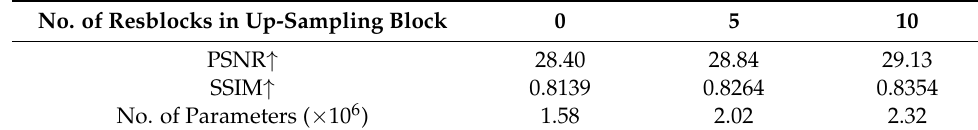
Table 4. Verification tests to determine the optimal number of pixel-shuffle layers. Each test result Table 3. Verification tests to determine the optimal number of Resblocks in the up-sampling block. shows PSNR (dB), SSIM, and the number of parameters. Each test result provides PSNR (dB), SSIM, and the number of parameters.